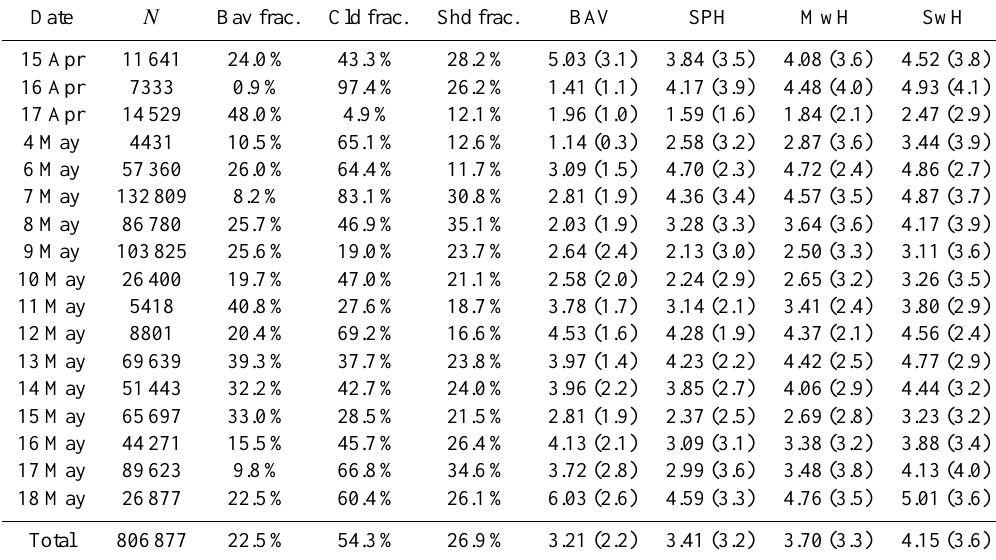
and then turns to the south. The wind direction is captured by the across-track wind speed estimate retrieved by ACM (Fig. 16e): positive values in the northern part of the plume indicate eastward (or southeastward) wind, while the values close to 0 in the southern part correspond to a zero across- track wind component. The BTD values are smallest in the middle of the plume in this case (Fig. 16f), but this is not a general